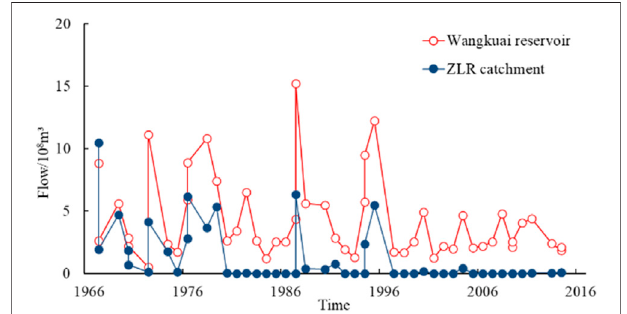
and Beiguocun hydrometric